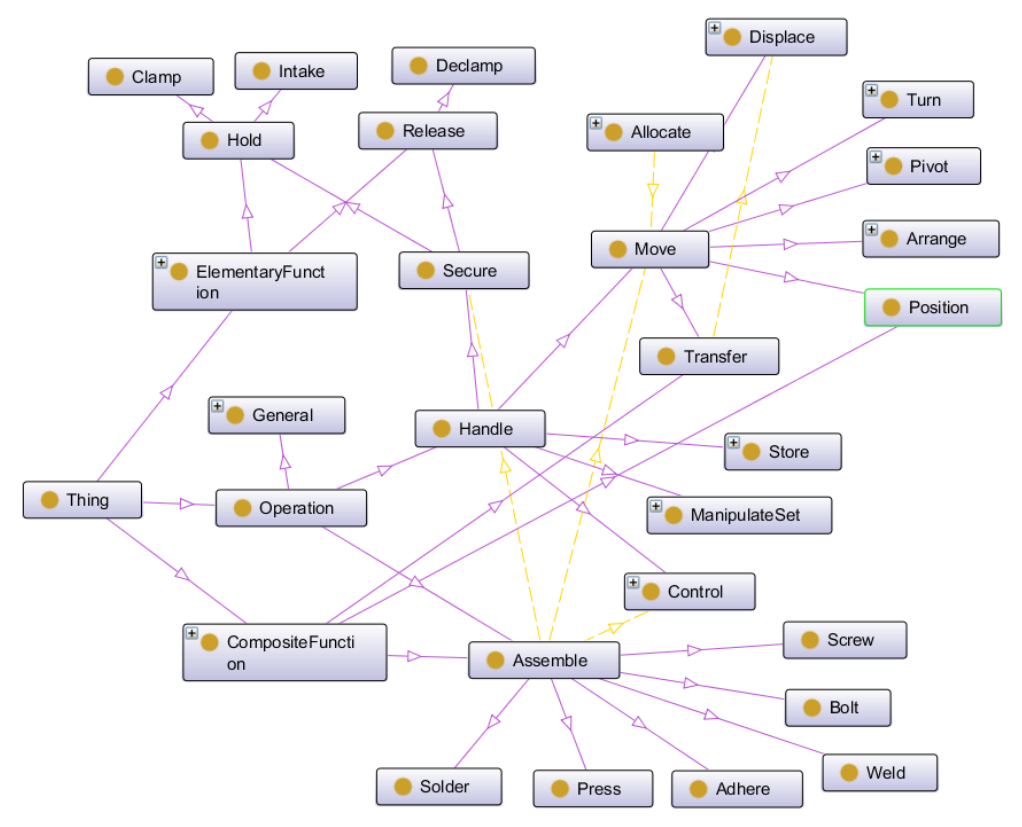
Figure 3. Part of the function